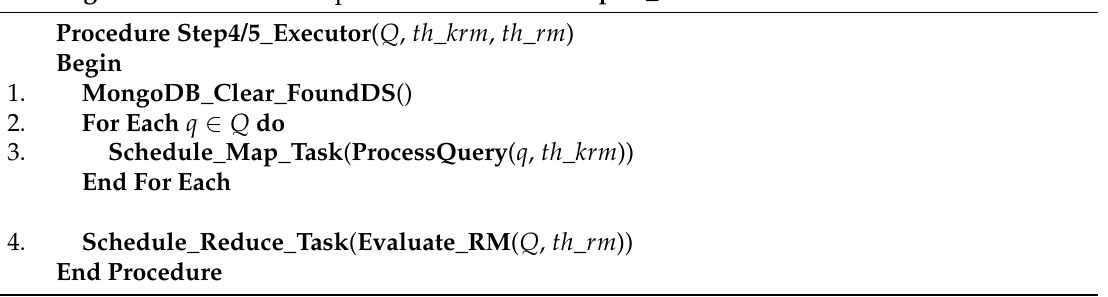
Algorithm 4: Generic Map-Reduce version of Step4/5_Executor